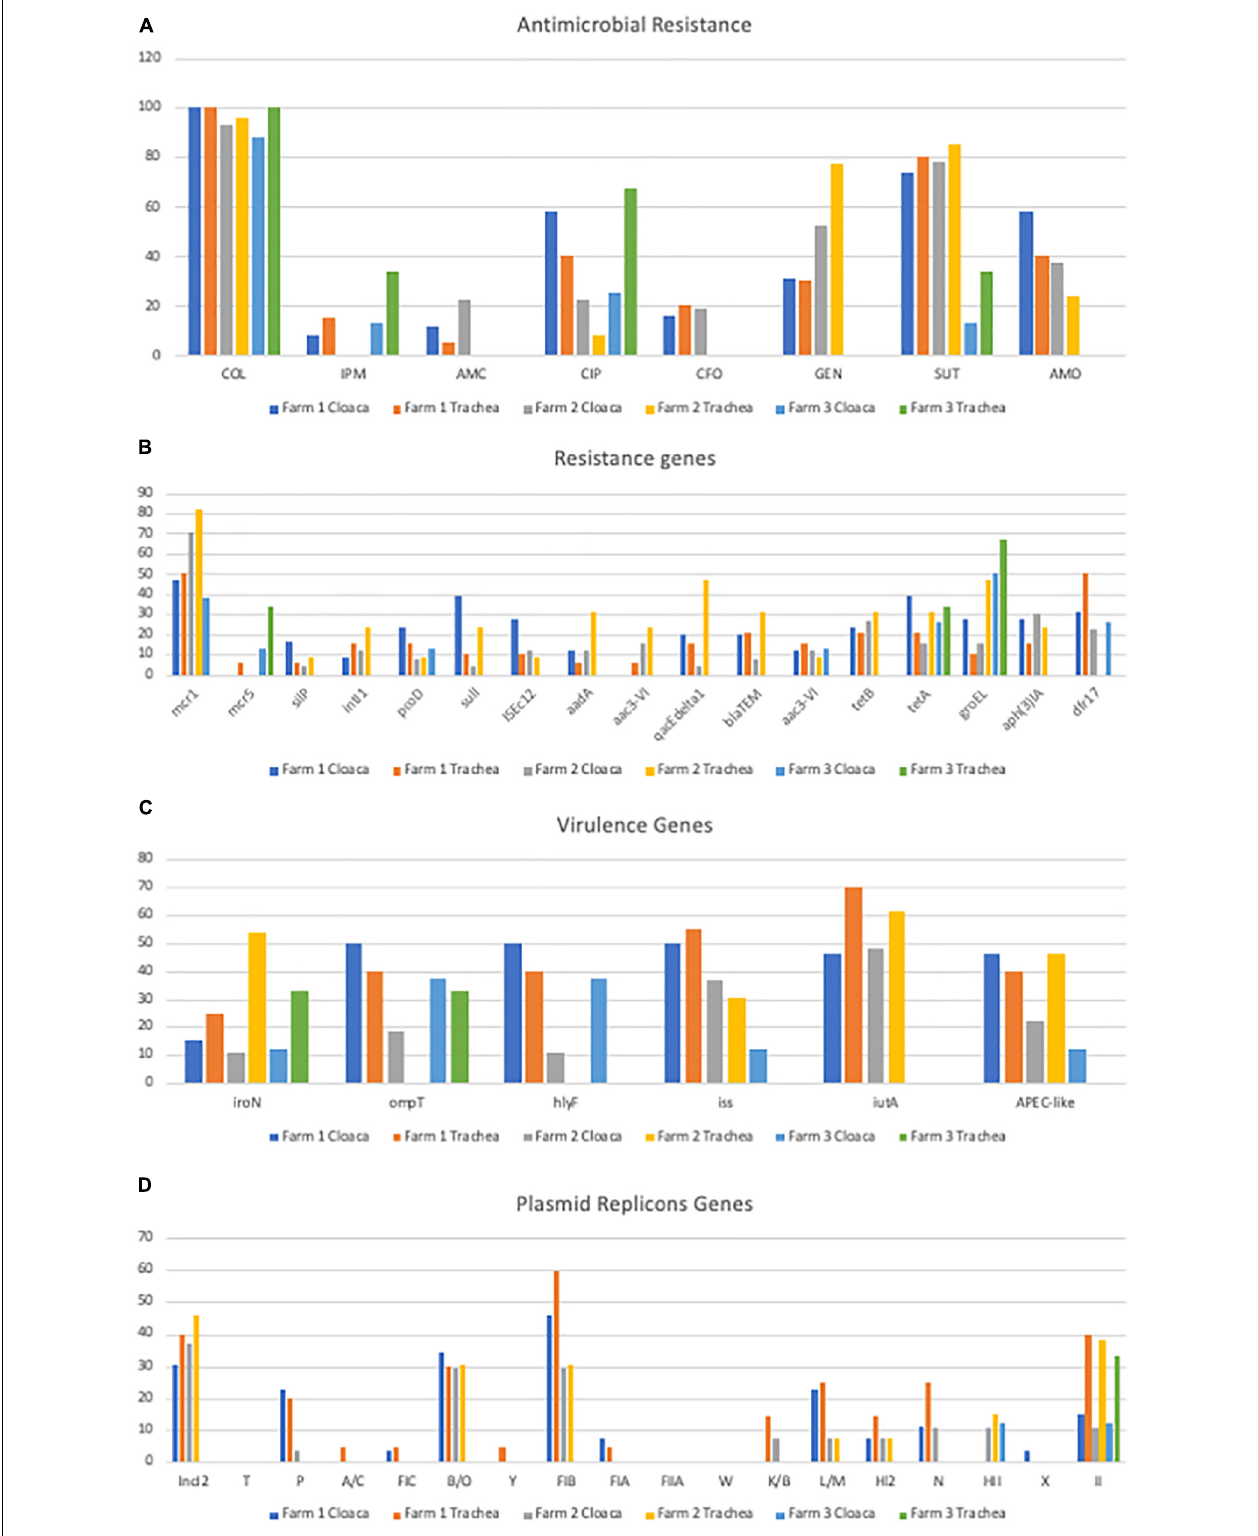
FIGURE 2 | Gene prevalence separated by organ and farm (A) Prevalence of Antimicrobial Resistance; (B) Prevalence of Genes Encoding Antimicrobial Resistance; (C) Prevalence of Genes Encoding Virulence Factors; (D) Prevalence of Plasmid Replicon Genes.